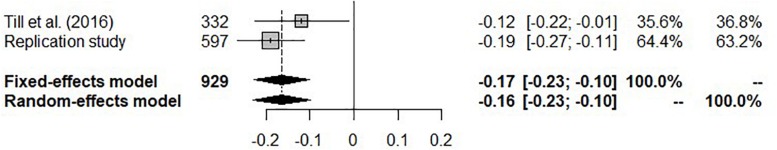
Forest plot for individual study results on the associations (Pearson correlation coefficients, r, along with 95% confidence intervals, CI) between age and performance on the death penalty questionnaire. The effect describes the relationship between participants’ age and the overall performance in the death penalty questionnaire, and meta-analytic quantification of the evidence for these associations. Study weight refers to the weight each study is assigned in fixed-effect and random-effects meta-analytic models.